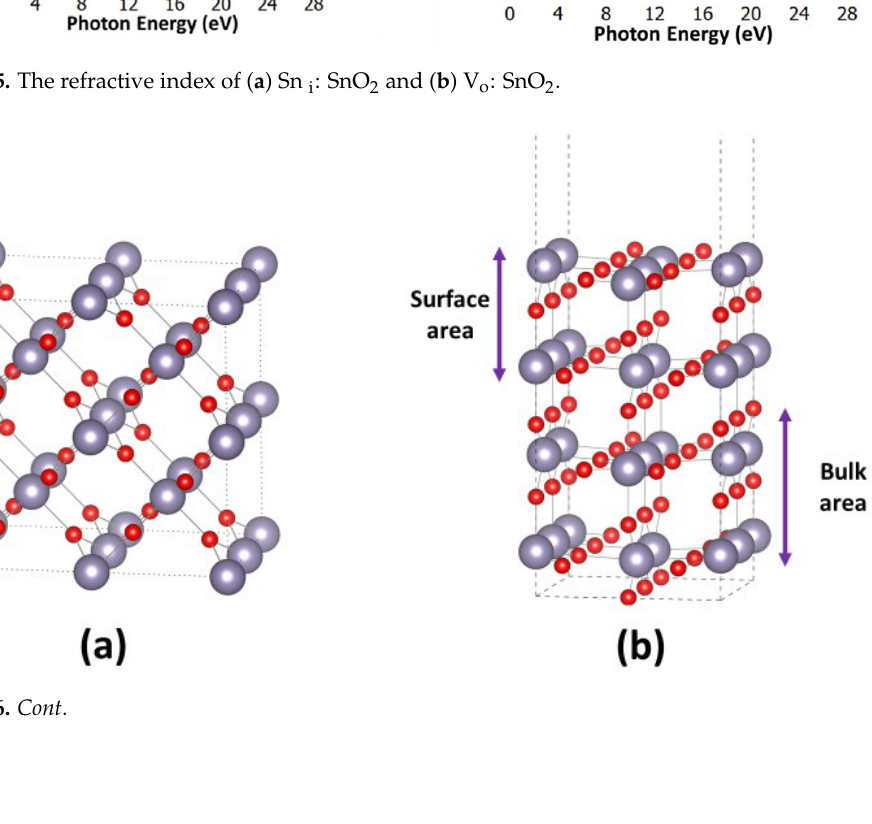
Figure 6. ( a ) The supercell, ( b ) the (110) surface model used, ( c ) the hydrogen interstitial in the (110) surface and ( d ) the bridge site adsorption on the (110) surface. The bandgap length and the large density of states at the conduction and valence band edges are the key parameters that affect the thermal and electrical properties of SnO 2 . We predicted the DOS and pDOS for the bulk and surface structures as presented in Fig- ure 7a,b, respectively. To tackle the bandgap underestimation problem, we employed the hybrid PBE0 functional, which provided a value of 3.35 eV, in good agreement with the reported experimental value of 3.7 [22]. As we predicted, the Fermi level was computed inside the bandgap, categorizing the pristine SnO 2 as a semiconducting material. From the DOS plot, we can see that O-2p mainly forms the valence band which ranges from 0 to − 7 eV, while the conduction band arises by the contribution of Sn-s and Sn-p orbitals as we have also described in previous studies [14,23]. To better understand the interaction of the hydrogen atom and molecule with the (110) surface of the SnO 2 , the electronic structure in Figure 7c,d was analyzed. We predicted that the O 2c site would be the most energetically advantageous position for H 2 absorption; hence, we used this position in our analysis.